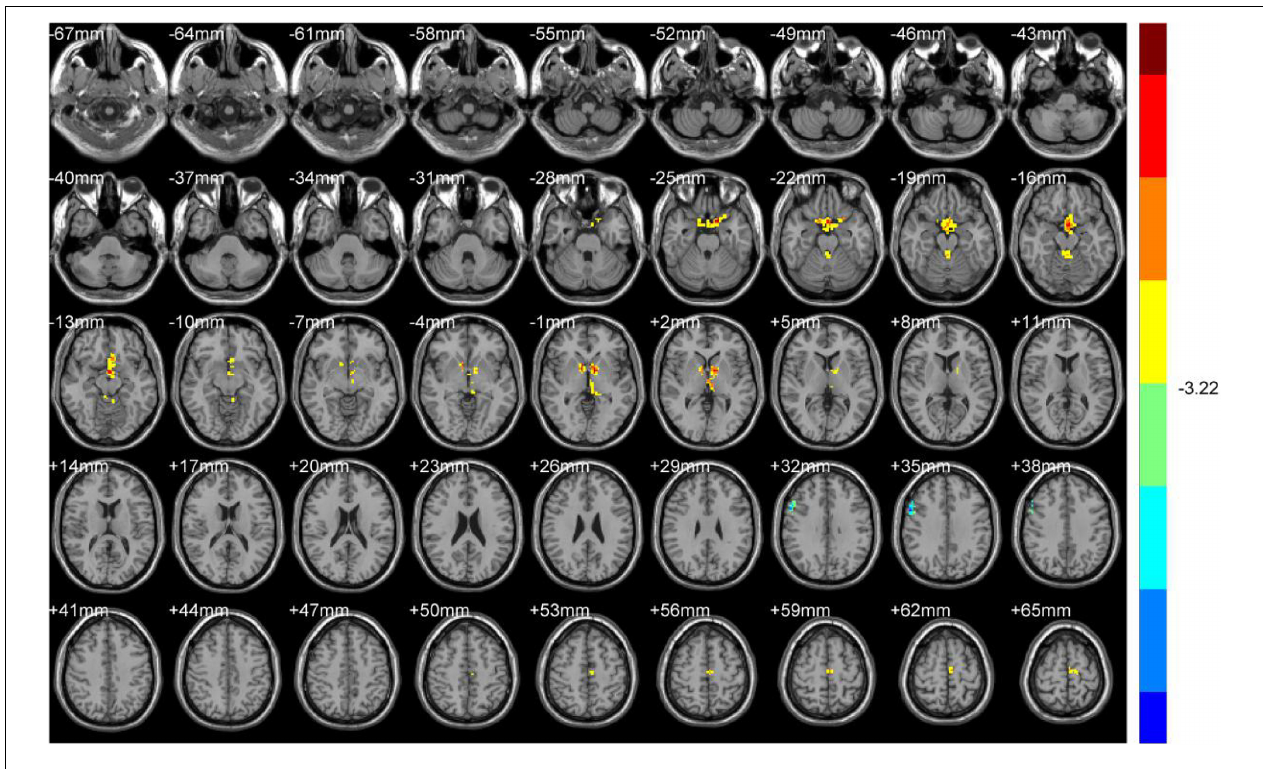
FIGURE 4 | ALFF (Non-dominant hemisphere vs. Normal).